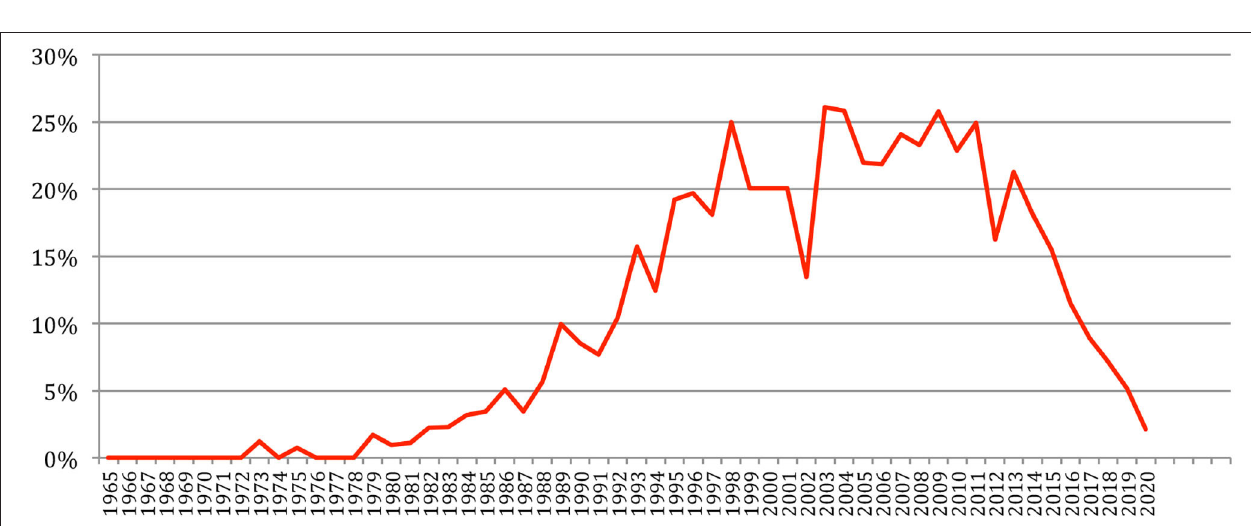
FIGURE 54 | Percentage of papers being reused by other papers over the